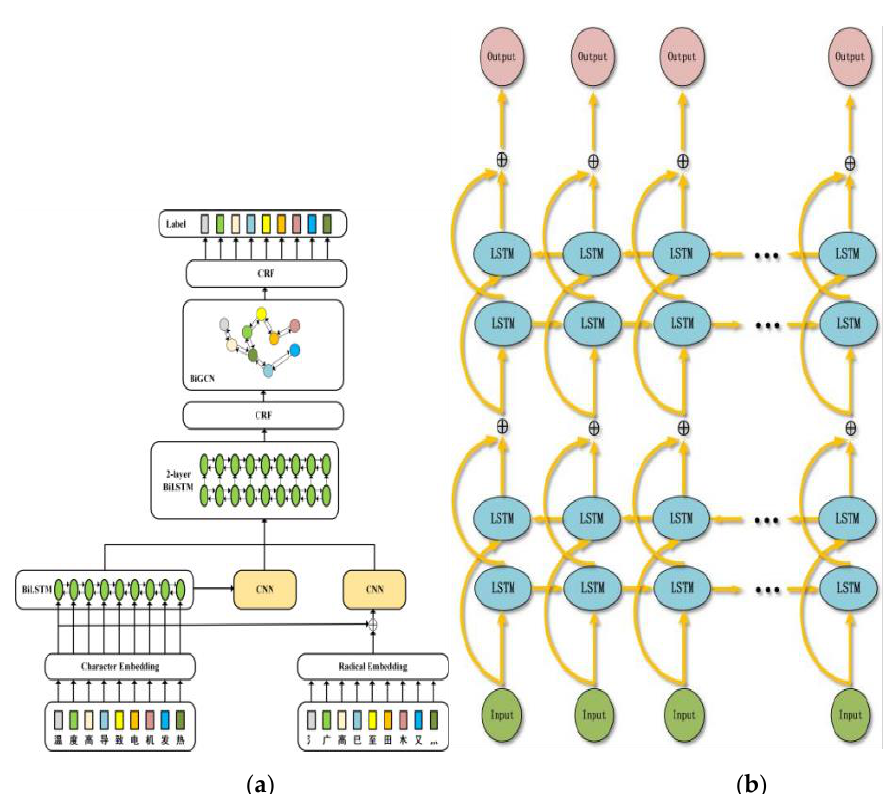
Figure 3. The structure of the model. ( a ) the text on the left means that high temperature causes the motor to heat up. ( b ) is the radical sequence of the left sentence.